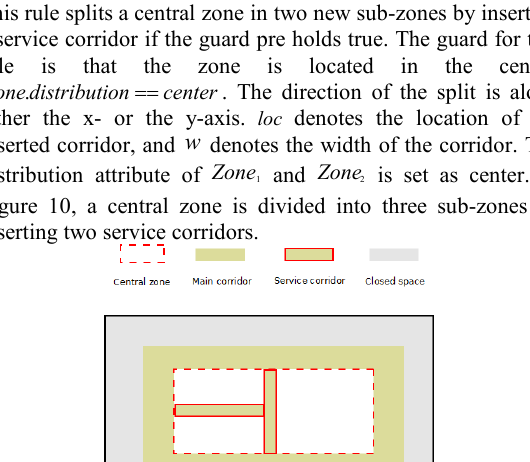
Figure 10. Split of central zones